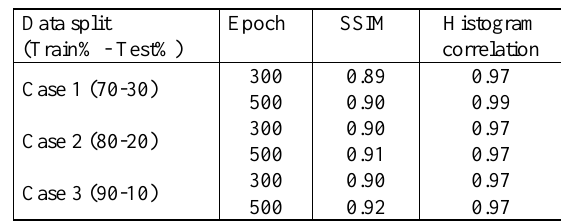
Table 1: The Structural Similarity Index Measure (SSIM) and Histogram correlation values obtained by comparing the annotated and output images generated by C-GAN when 70%, 80%, and 90% of the input images were used for training the algorithm under 300 and 500